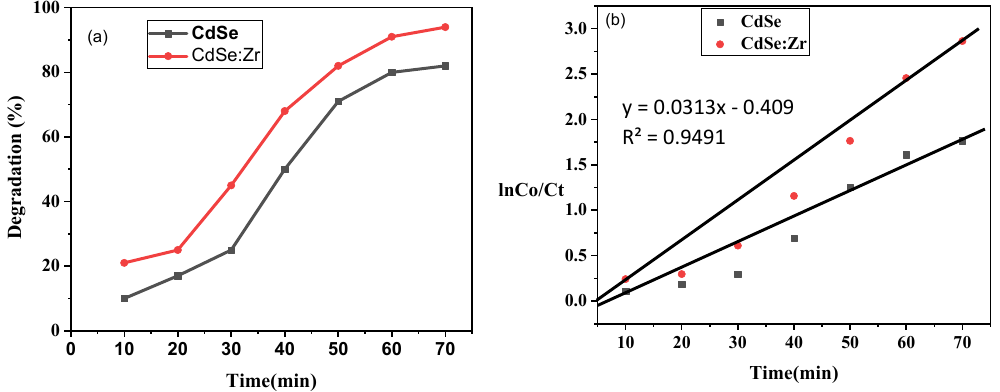
Fig. 7. Effect of irradiation time (a) and photodegradation kinetics (b) of IC